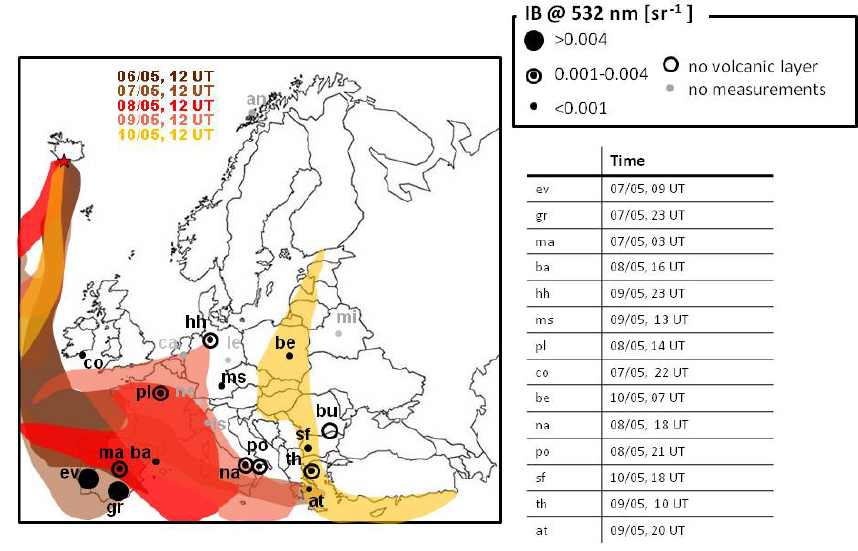
Fig. 12. Map of Europe showing the dispersion of the Eyjafjallaj¨okull (red star) volcanic aerosol plume during the 6–10 May 2010 period. The approximate location of the plume in the 3–5km height range is given for 12:00 UT on 6 May (dark brown), 7 May (light brown), 8 May (dark red), 9 May (light red), and 10 May 2010 (yellow). The maximum integrated backscatter (IB) at 532nm measured by each station is reported in black. The exact time location of the maximum IB reported is reported in the